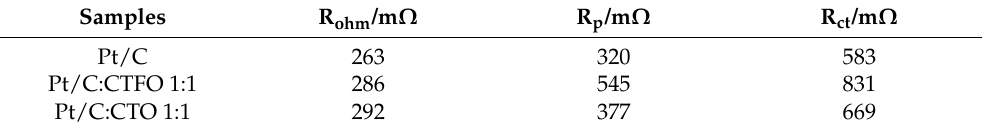
Table 3. Resistance values for all catalyst compositions from EIS at 0.6 V under 30% RH and 80 °C. Samples